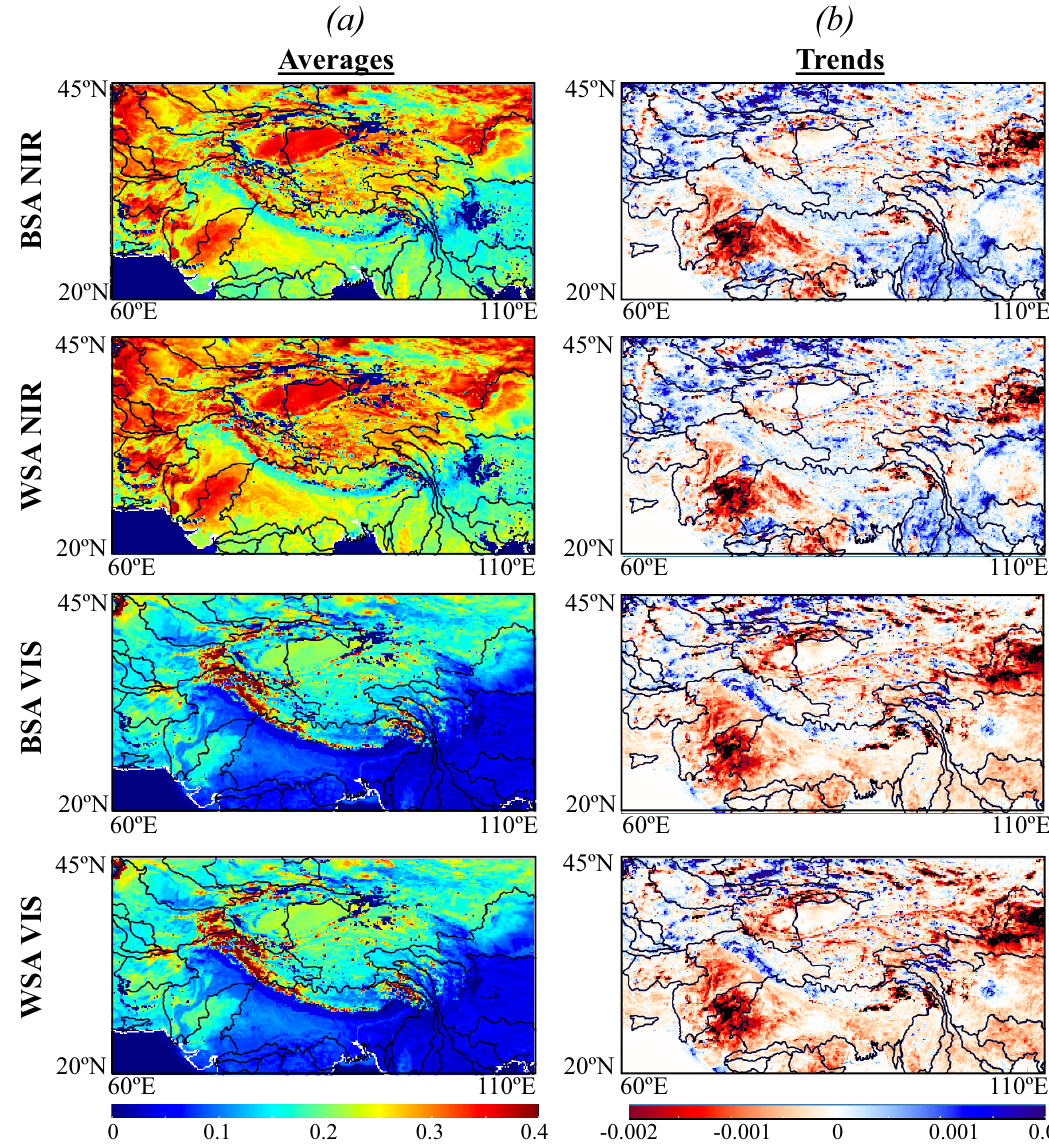
Figure 2. Surface albedo changes and values in High Mountain Asia. Spatial distributions of the yearly ( a ) averages and ( b ) trends from 2003 to 2020 of BSA (Black Sky) and WSA (White Sky) surface albedos in both NIR and VIS wavelengths. Trends were computed using the Mann–Kendall test with a confidence level of